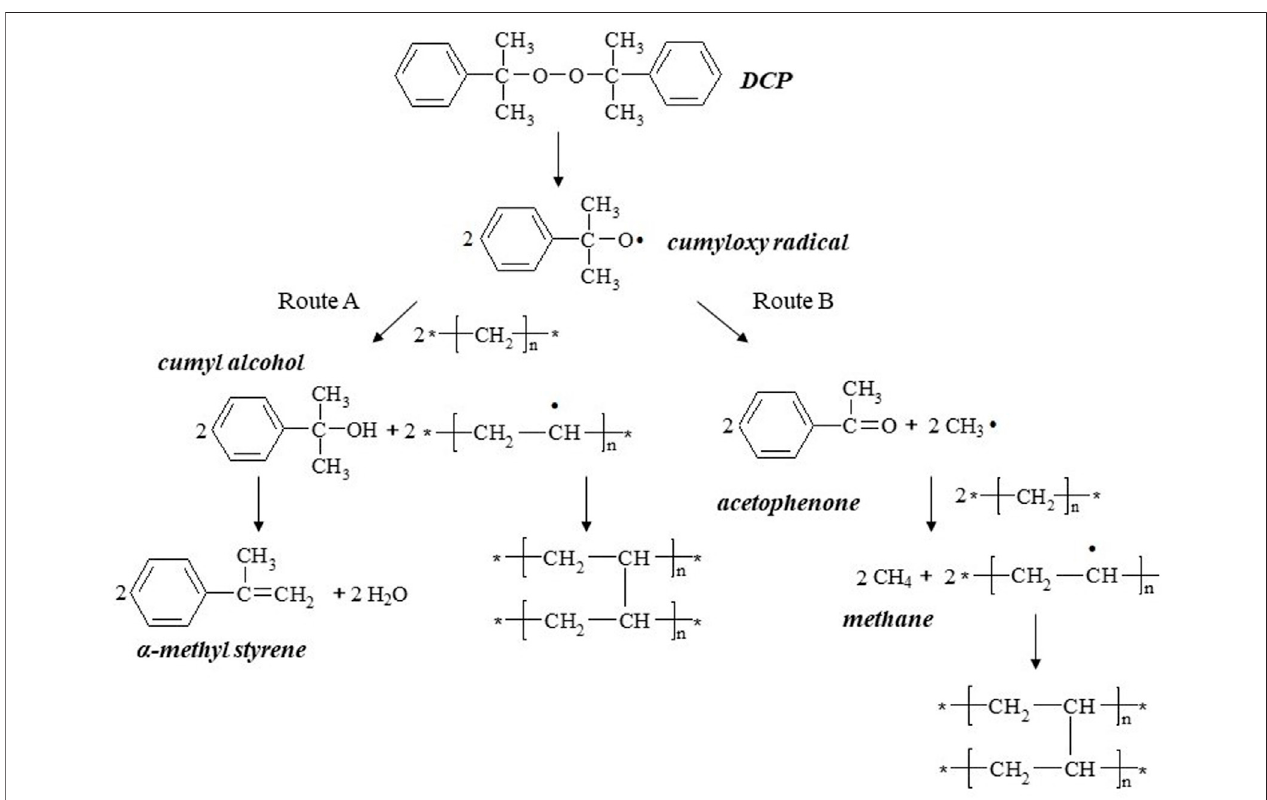
FIGURE 1 | Cross-linking reaction of polyethylene initiated by DCP (Andrews et al., 2006).